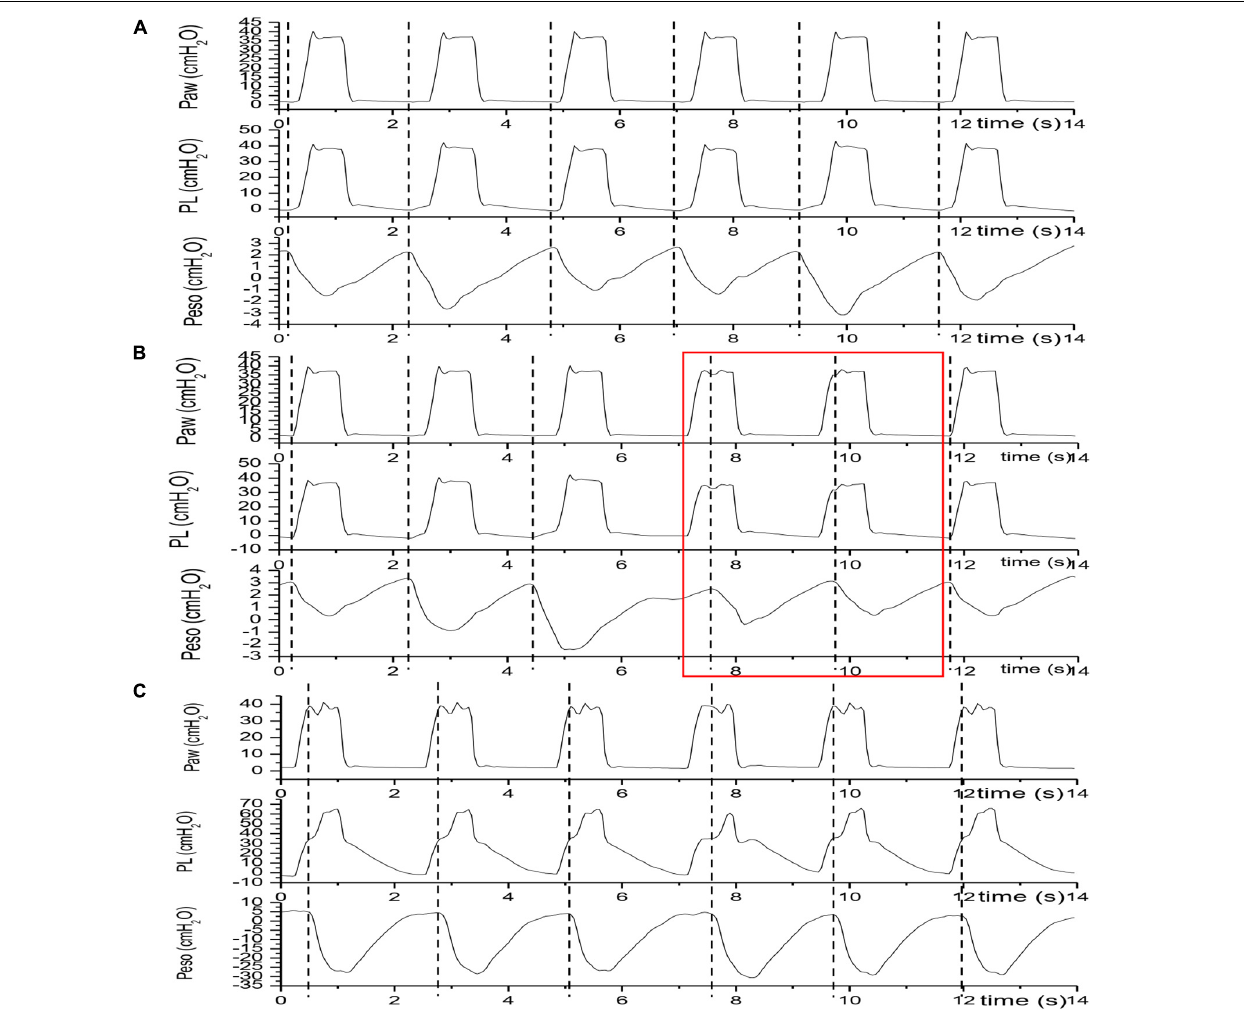
FIGURE 4 | Transition from assist mechanical breath to intermittent (unstable) reverse trigger and stable reverse trigger. Traces were acquired in patient No.2. Dotted line denoted the initiation of each neural breath. Panel (A) showed that each neural breath arose before a mechanical breach initiation or the phase delay > 0 (Assist breath); Panel (B) showed the coexistence of Assist breath and Control breath with stable reverse trigger. The red solid line box included two Control breath with stable reverse trigger (the 4th and 5th breath). Panel (C) showed that each neural breath arose behind a mechanical breach initiation or the phase delay < 0 (Control breath with stable reverse trigger). Paw, airway pressure; PL, transpulmonary pressure; Peso, esophageal